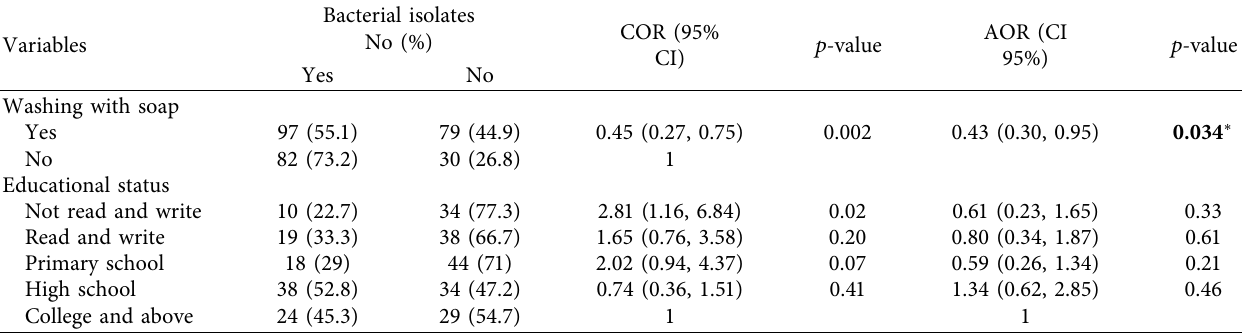
Table 4: Bivariate and multivariable analysis of bacterial infection of the eye among external ocular infections at Karamara hospital, Jigjiga, Ethiopia,